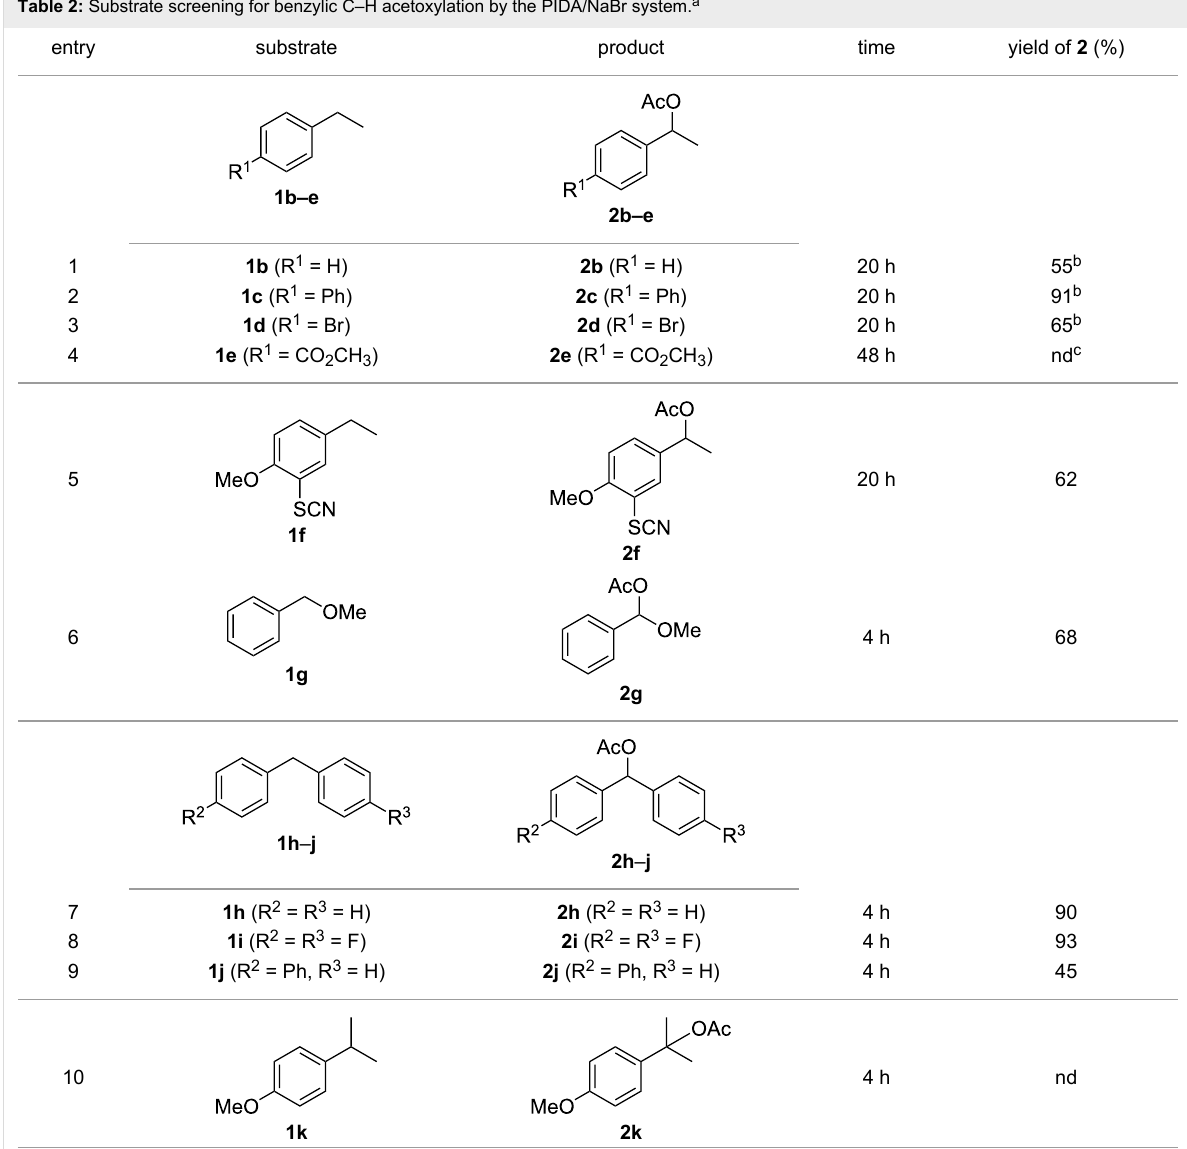
Table 2: Substrate screening for benzylic C–H acetoxylation by the PIDA/NaBr system.